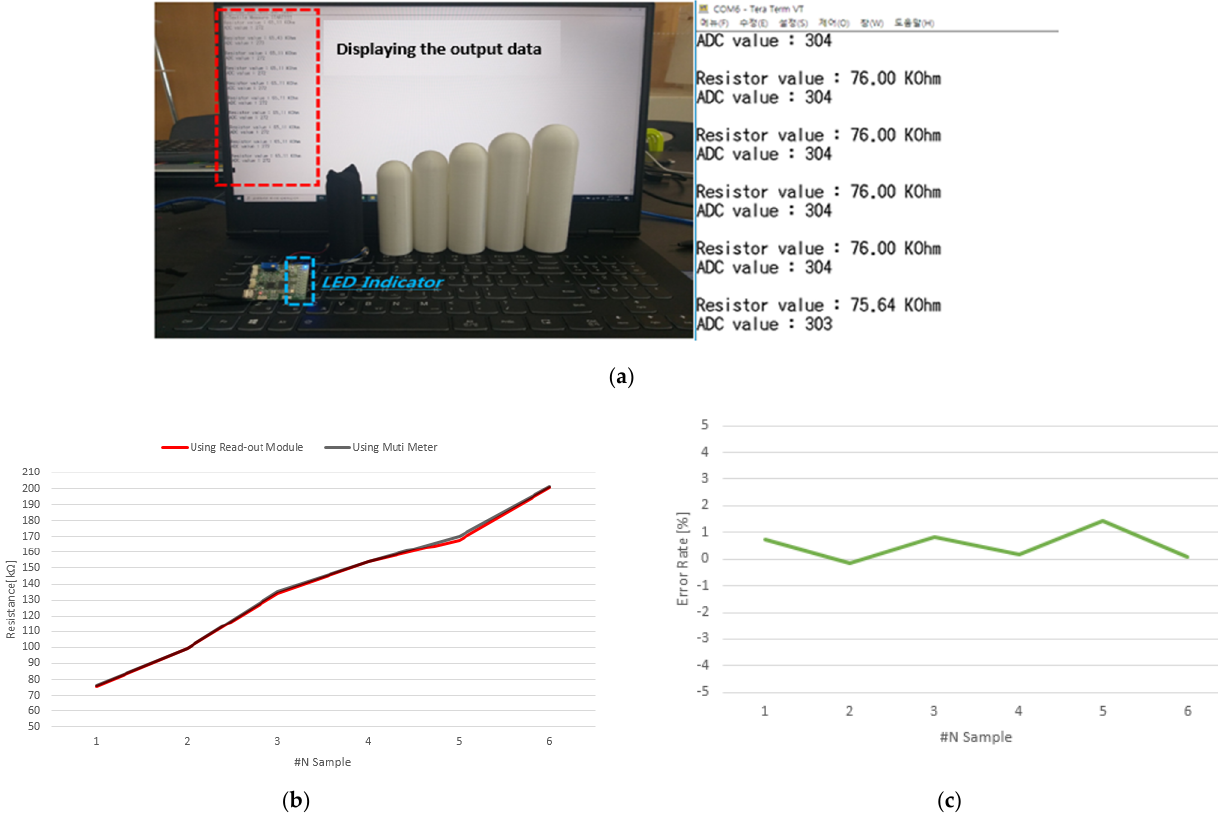
Figure 7. ( a ) Output data using a wireless sensor module. ( b ) Graph of comparison between measured and output resistance values. ( c ) An error graph of the output resistance value and the measured resistance value.